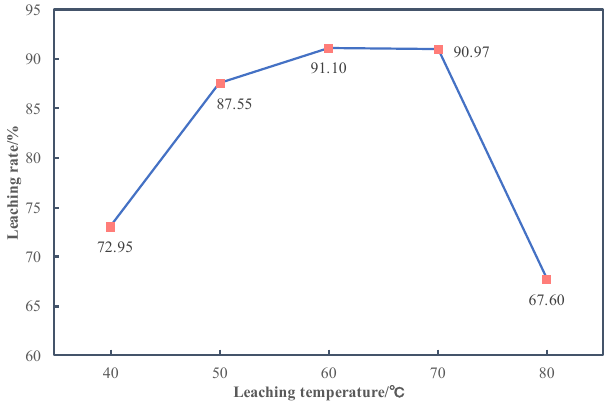
Figure 4. Effect of temperature on leaching rate of titanium.